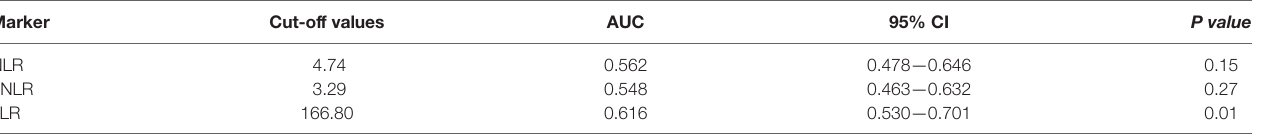
TABLE 2 | Determination of the optimal cut-off